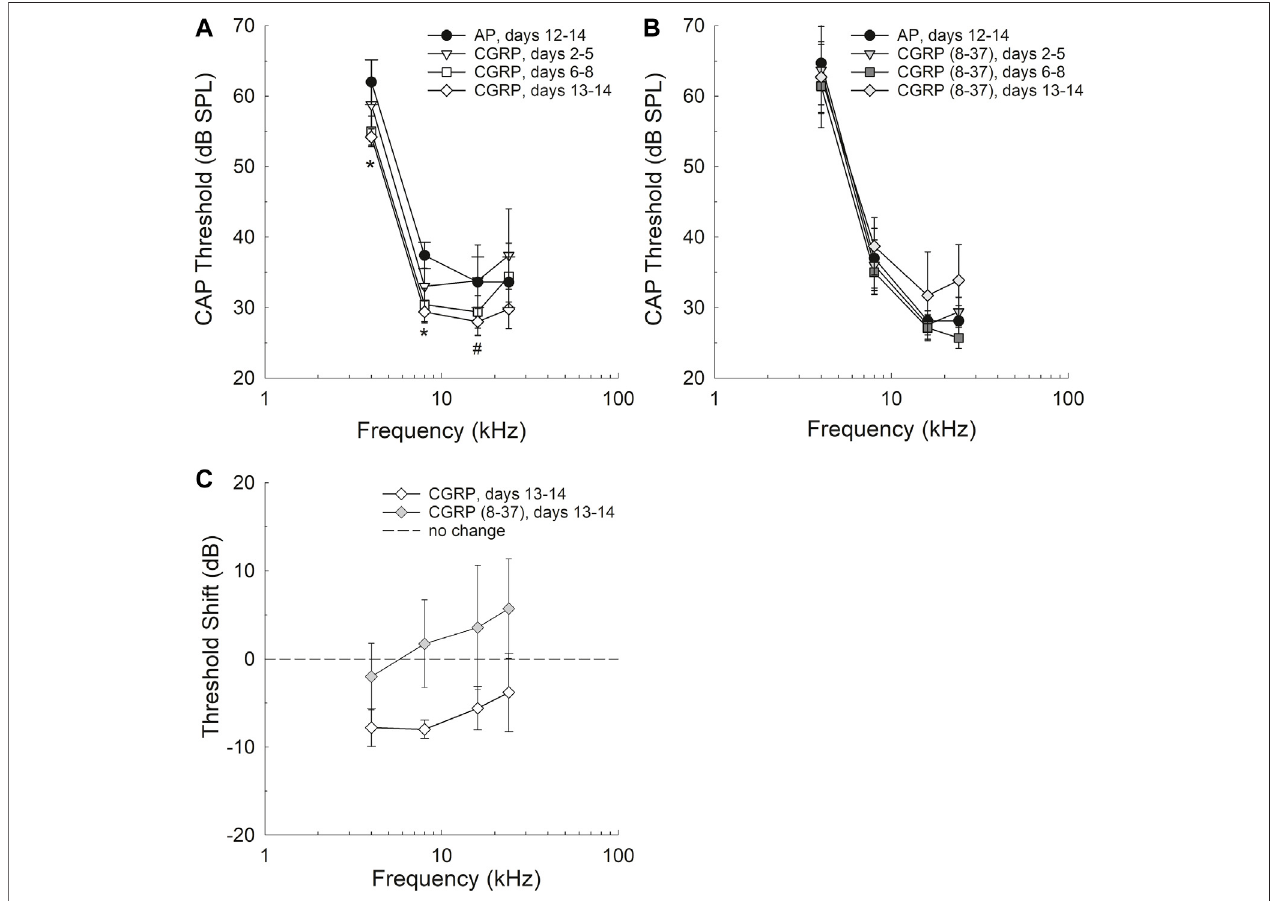
FIGURE 1 | Threshold sensitivity was improved after 13 – 14 days of CGRP agonist infusion, but not at earlier infusion times including days 2 – 5 and 6 – 8 (A) . Differences between APand CGRPthresholds werestatistically signi fi cantat 4and 8 kHz(see asterisks) and approached statistical signi fi cance at 16 kHz( p (cid:1)